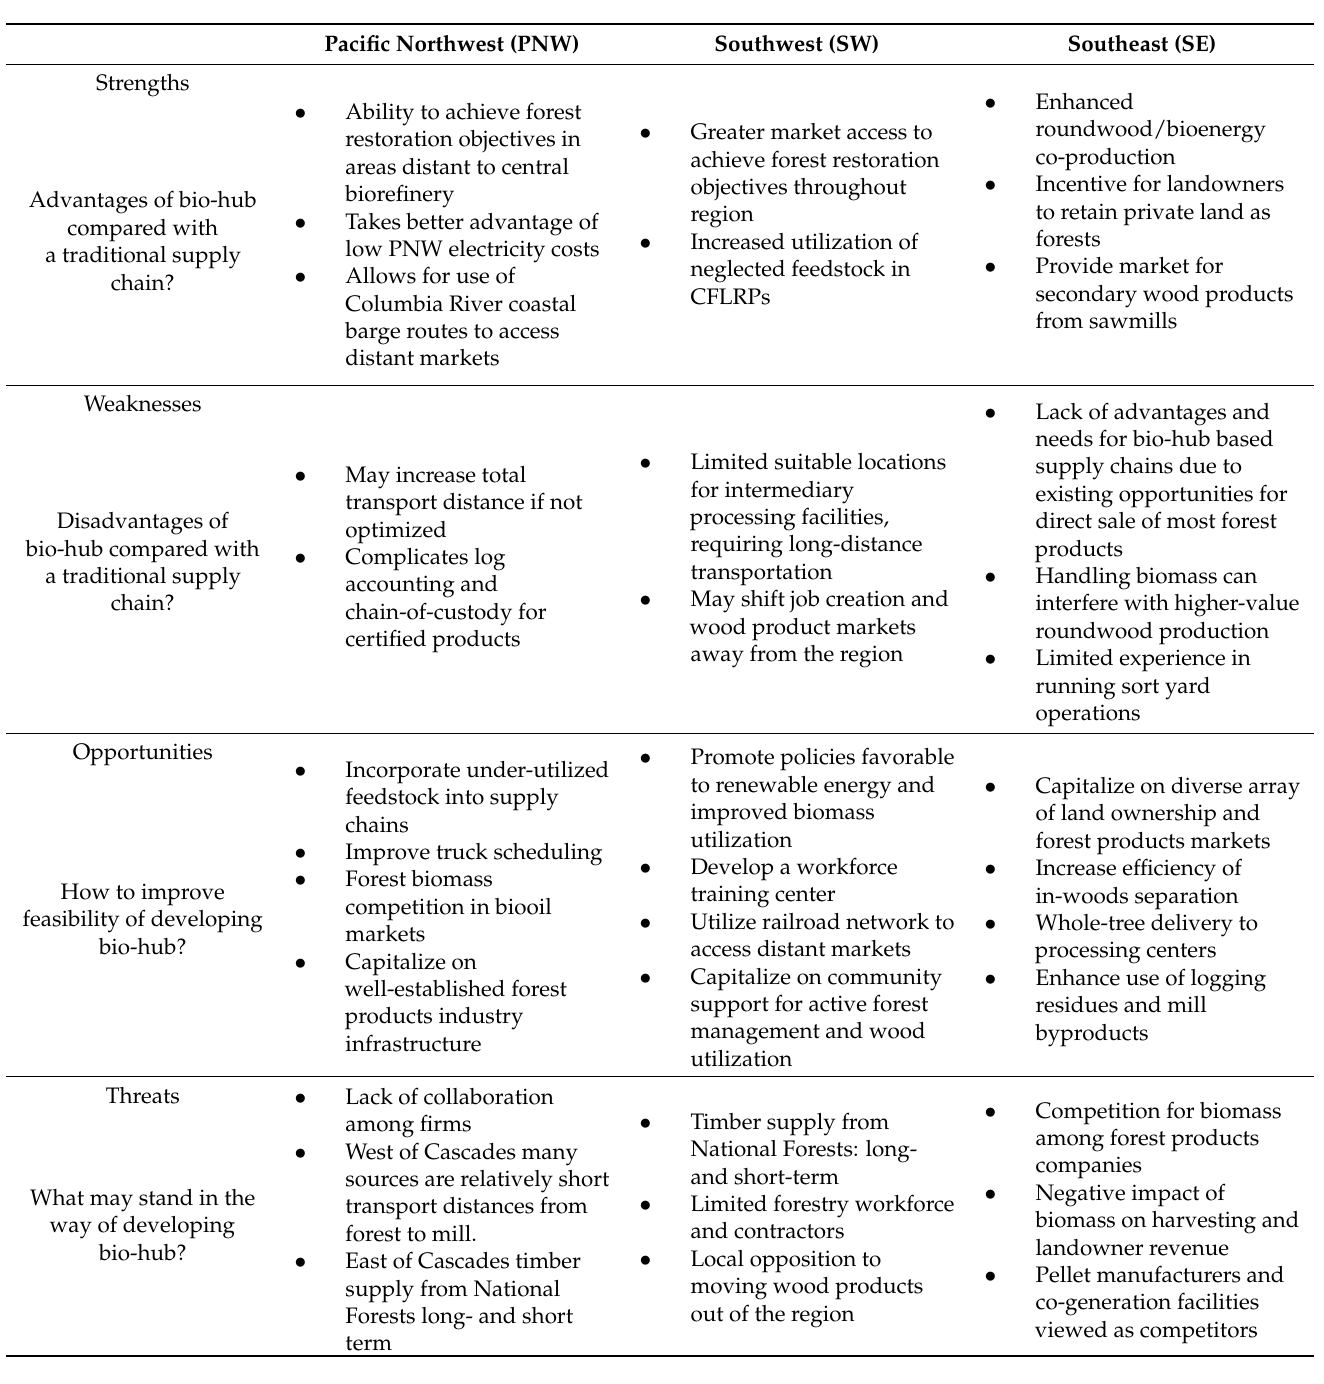
Table 1. Regional summary of strengths, weaknesses, opportunities, and threats of a bio-hub model compared with traditional supply chains. General items (not specific to a region) are discussed in the paper’s